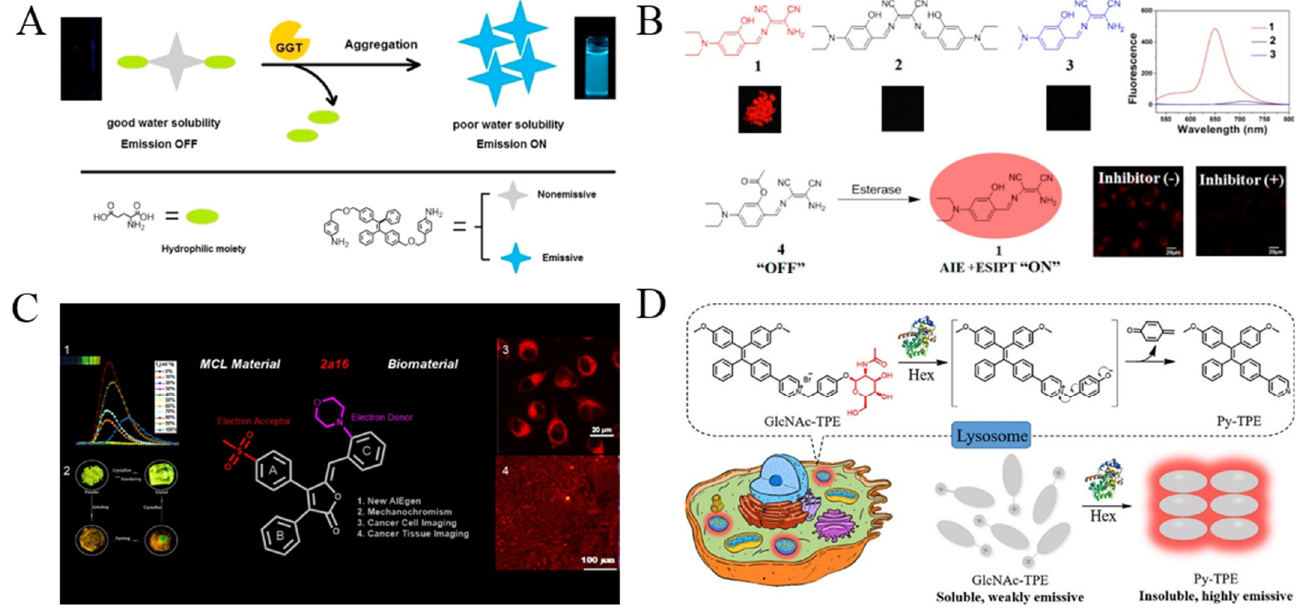
Figure 12. ( A ) Schematic illustration of the probe’s fluorescent detection for GGT. Reprinted